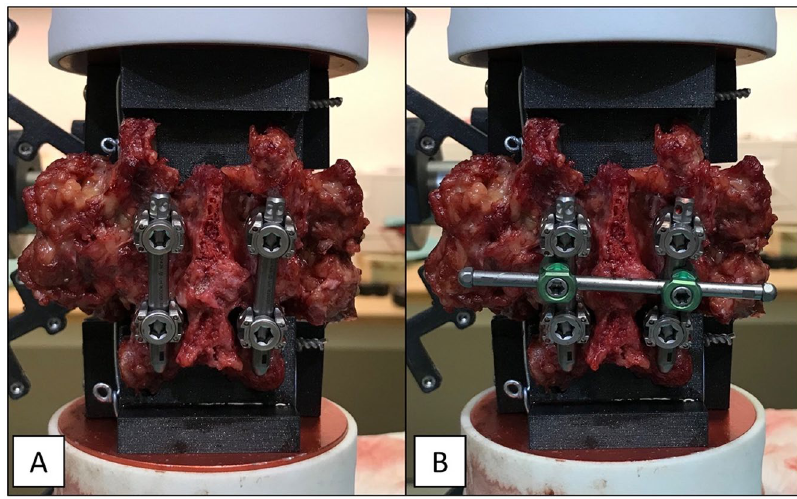
Figure 2. Image of a dorsally instrumented spinal segment ( A ) without and ( B ) with